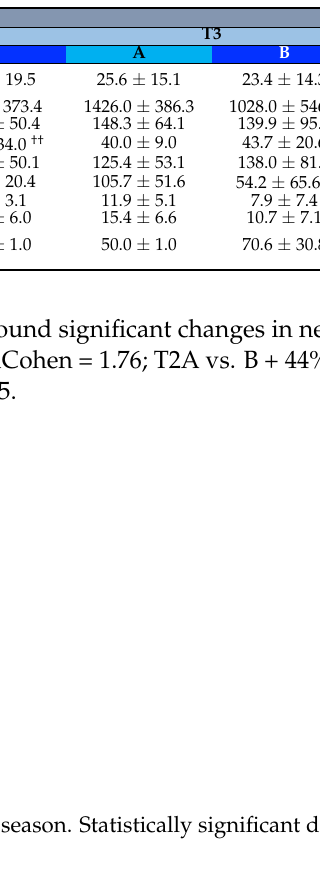
Table 2. Urea, uric acid, electrolytes (Na, K, Cl, P, Mg, and Ca), and total proteins at the baseline (T0), during (T1-T3), and after the season (T4). Data are displayed as mean ± SD. Statistically significant differences symbols: * p < 0.05 respect T0; † p < 0.05, †† p < 0.01 post (B) respect to pre (A). The colors of the time boxes (from T0 to T4), are the same as those reported in the histograms of figures from 2 to 4, to help the reader.